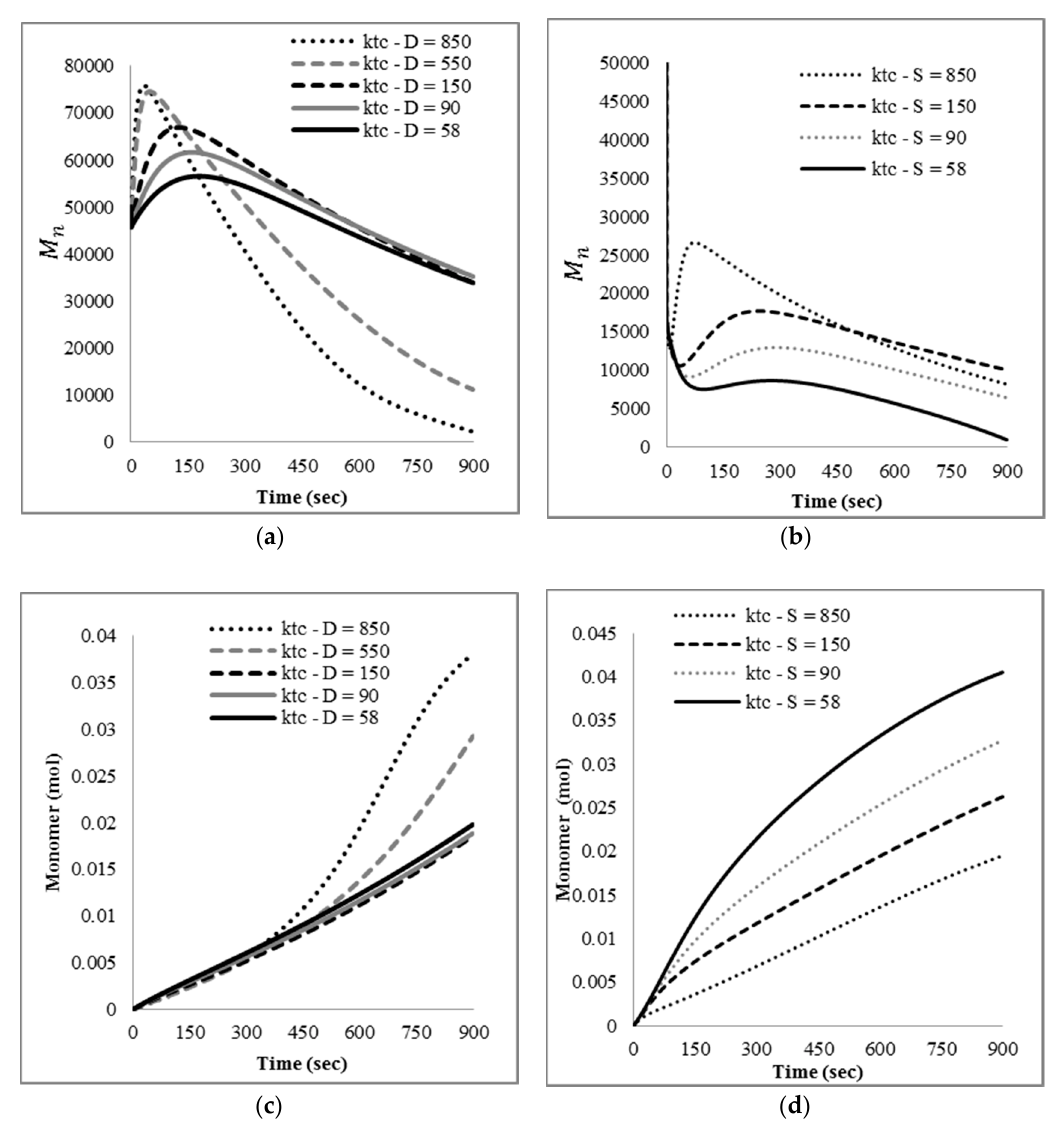
Figure 9. Effect of the variation of the termination by combination coefficient, k tc , value on the pyrolysis M n evolution of ( a ) dead polymer and ( b ) dormant polymer, and on the monomer generation of ( c ) dead polymer and ( d ) dormant polymer.